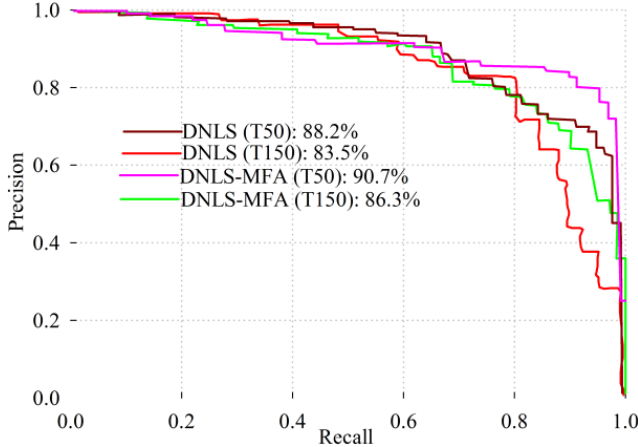
Figure 7. Comparing the predictability level of optimum multitask and hybrid DNLS models using the AUC ROC of conducted precision – recall curves. the AUC ROC of conducted precision–recall